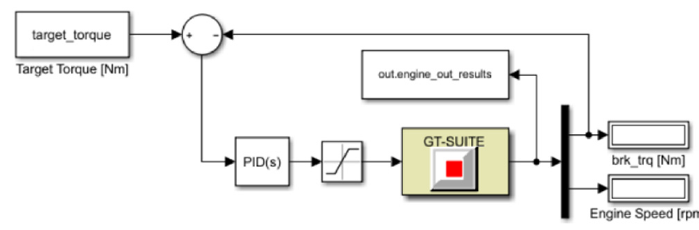
Figure 4. Simulink PID controller for the operating condition reproduction.